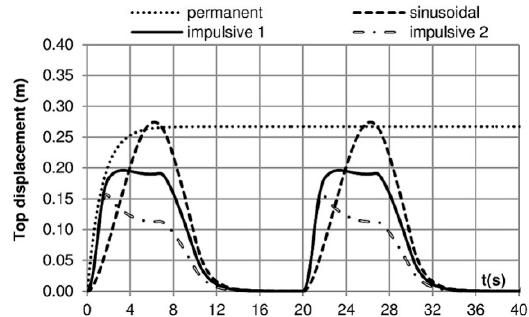
Figure 9. Expected movement on the top of the foundation: E (MPa) = 10; 2 load cycles.